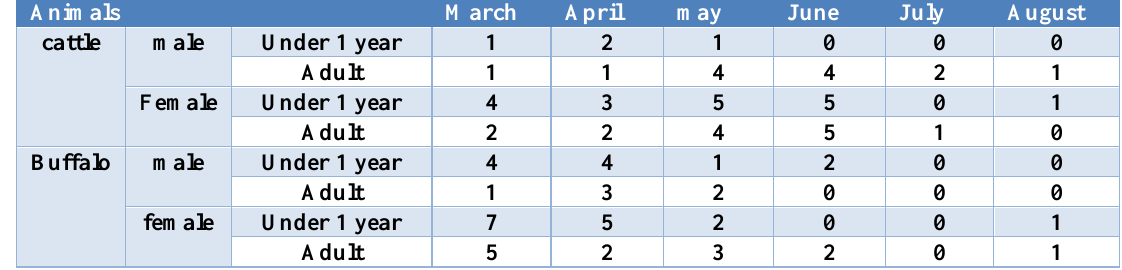
Table, 1: Numbersof infected animals with HS according to month of the study Animals